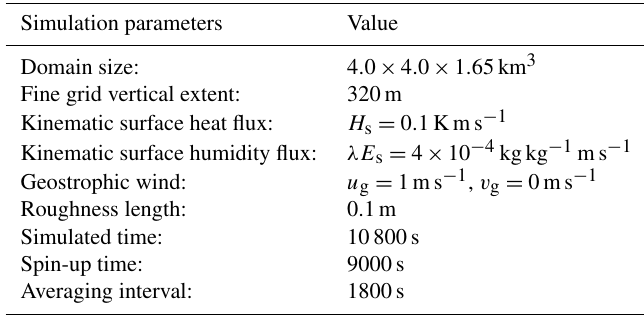
Table 2. Simulation parameters for the nesting validation test.